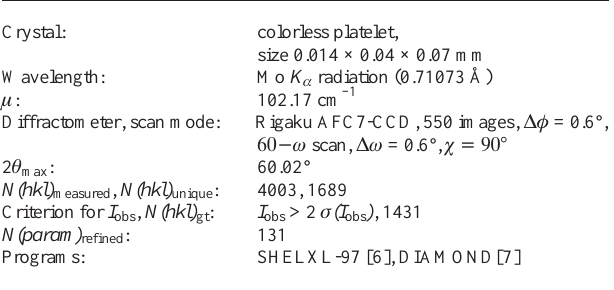
Table 1. Data collection and handling.